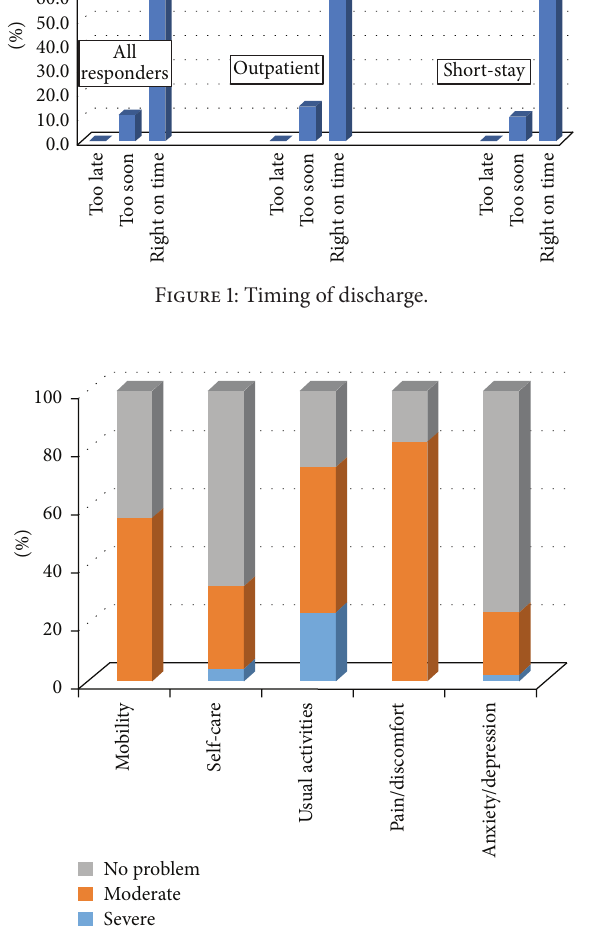
Figure 2: EQ-5 patient responses (all patients).